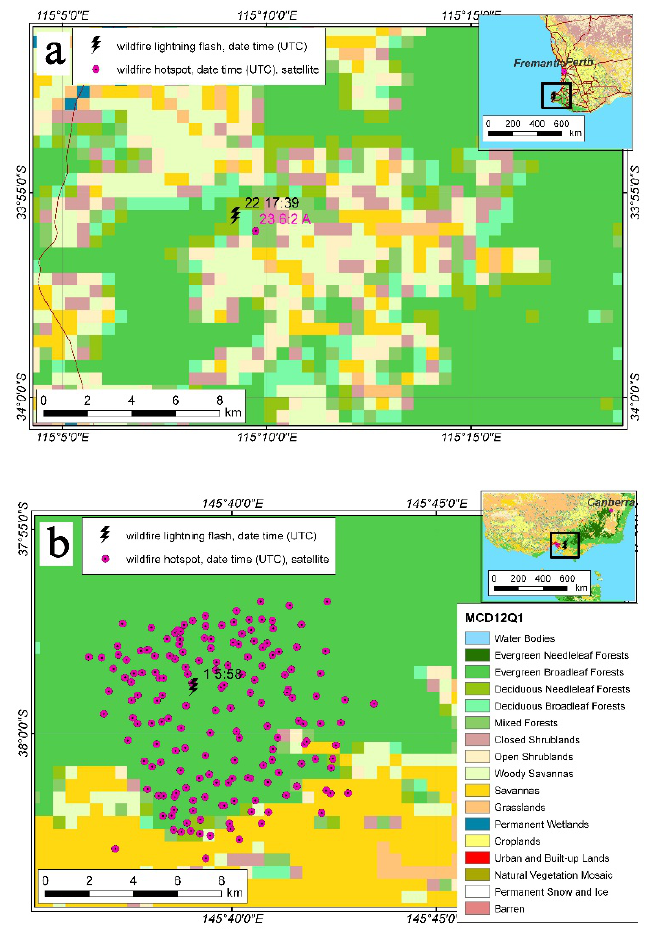
Figure 11. The spatial distributions of ISS LIS lightning flashes and the MODIS active fires that were recorded on 22 October 2020 ( a ) and on 1 March 2019 ( b ) in the Australian forests are shown. The study case ( a ) corresponds to a single active fire (AF) MODIS pixel, extinguished the next day, and ( b ) represents uncommon massive wildfire hotspots, which spread rapidly during next two days.